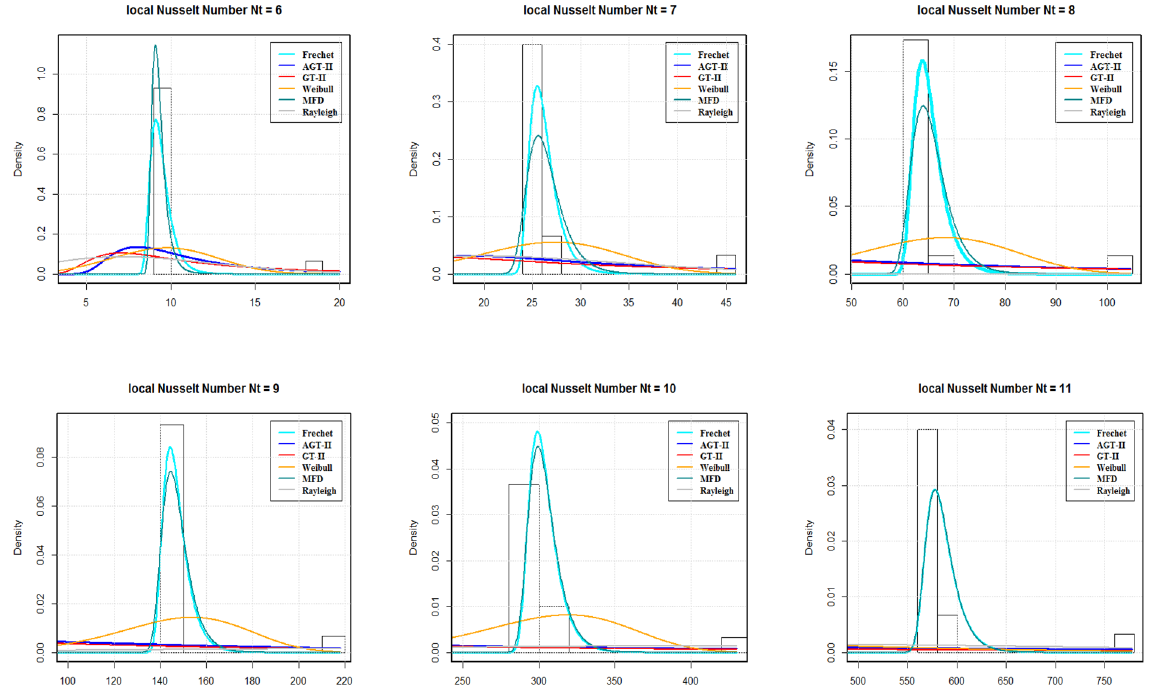
Figure 5. The estimated densities for the